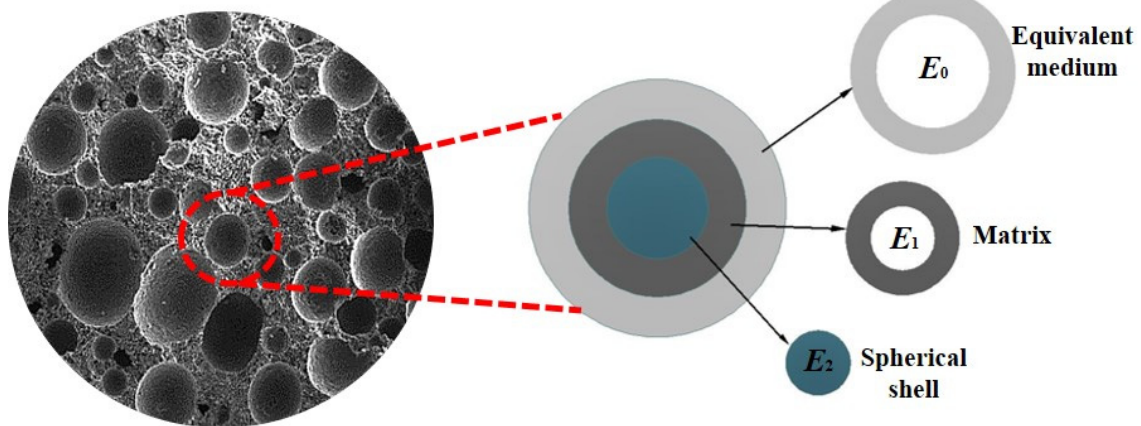
Figure 4. Two-layer embedded model of foamed concrete.